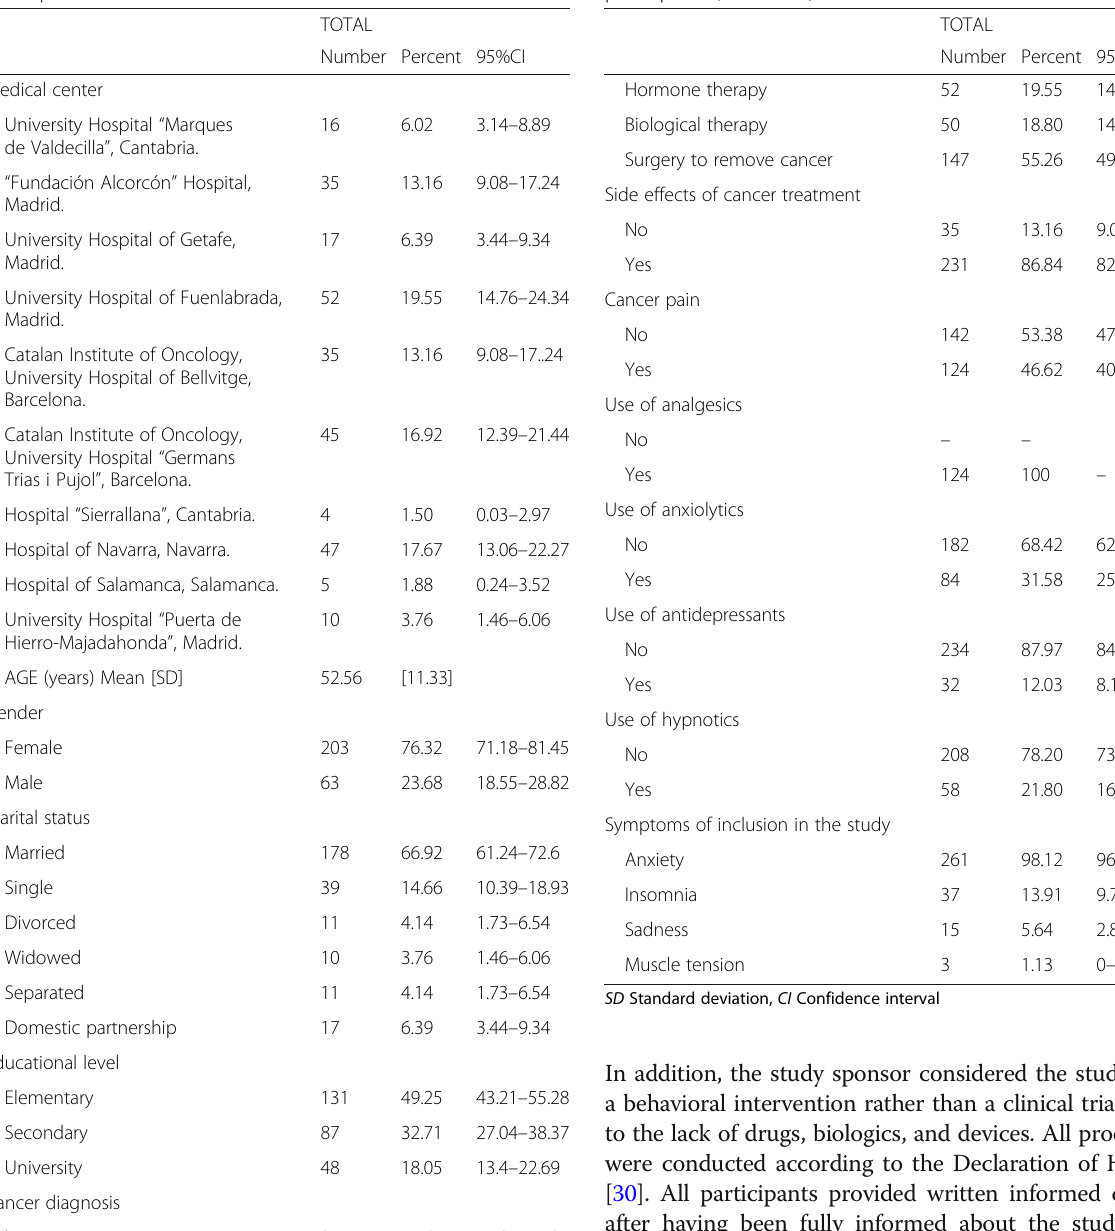
Table 1 Sociodemographic, medical characteristics on study participants